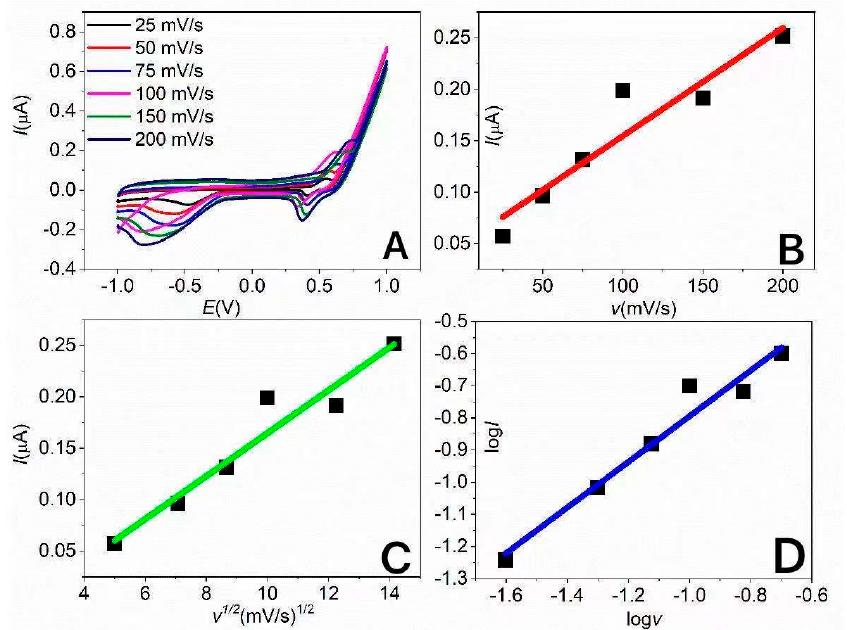
Figure 9. Cyclic voltammograms of 10 µ M insulin on SPCE/MWCNT/NiO1.5 at different scan rates ( A ). The dependences of the peak current on scan rate ( B ), peak current on the square root of scan rate ( C ), and of logI on logv ( D